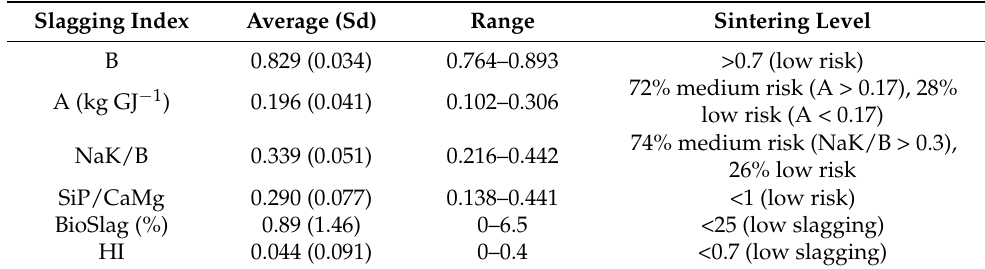
Table 4. Slagging indices calculated on the basis of ash composition at 550 ◦